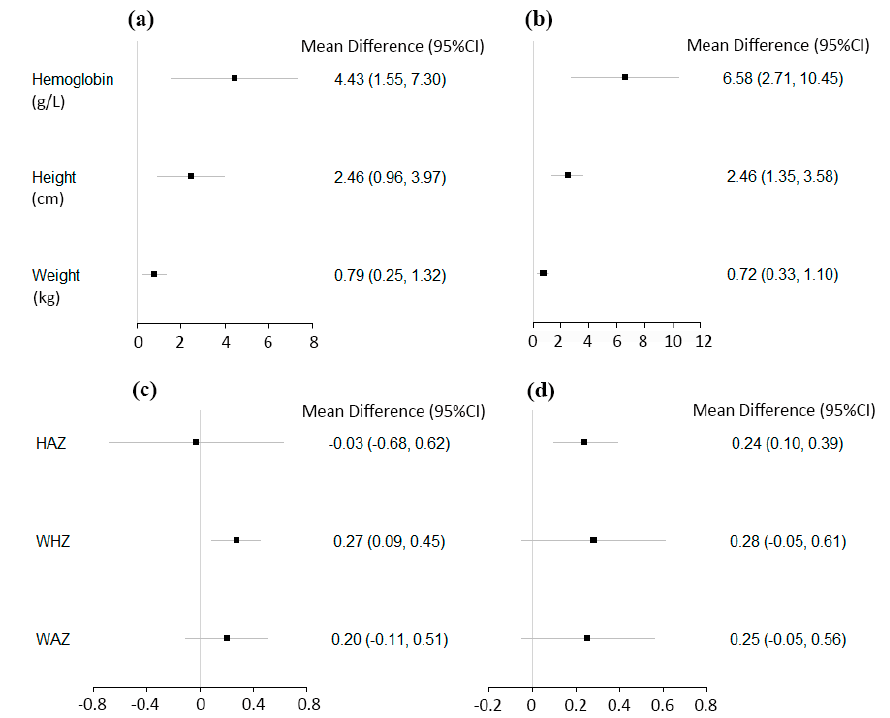
Figure 2. The effect of Yingyangbao (YYB) on continuous hematologic and anthropometric outcomes among post-only studies with concurrent-control ( a , c ), and pre-post studies ( b , d ) in China.